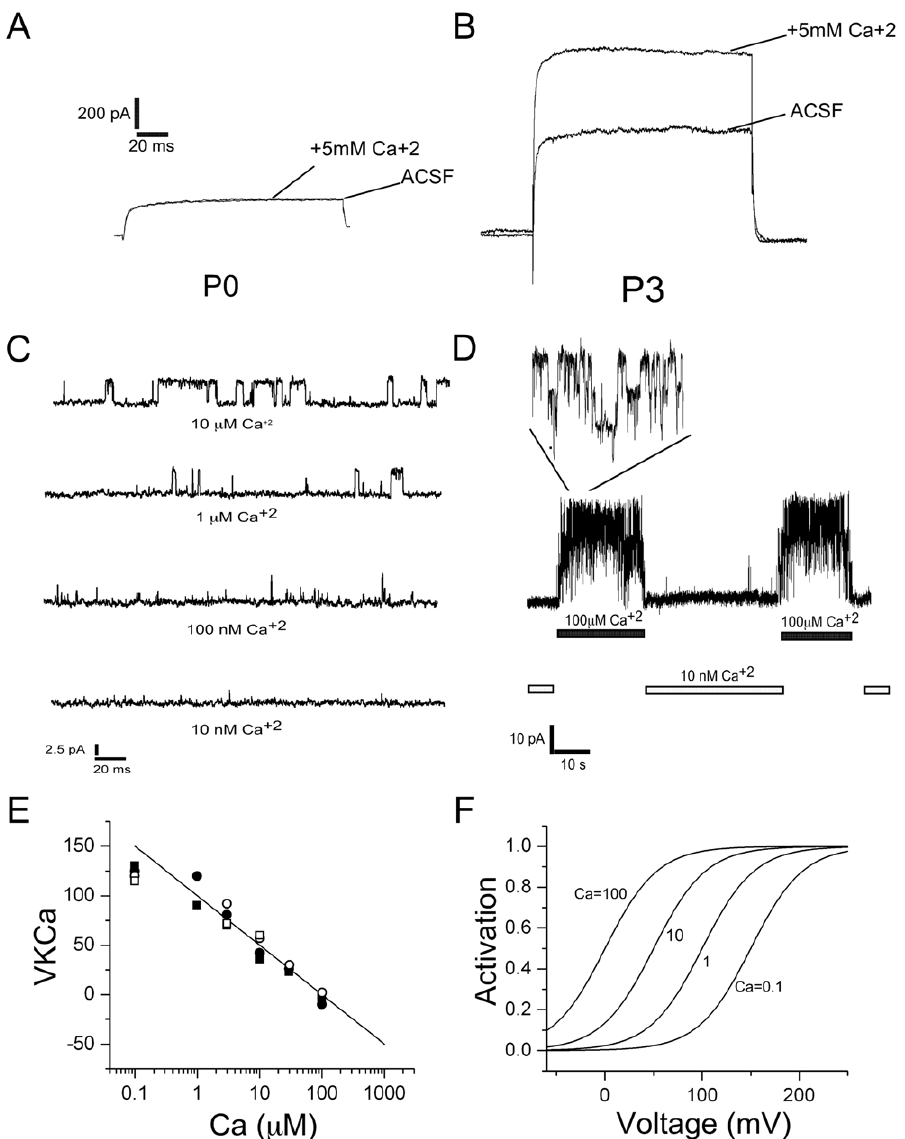
Figure 9. Ca 2 z sensitivity of the outward current and single-channel recordings. (A) Outward current of a P0 neuron in regular ACSF (no calcium) and in ACSF + 5 mM CaCl 2 . (B) Outward current of a P3 neuron in regular ACSF (no calcium) and in ACSF + 5 mM CaCl 2 . CaAK channels activated by intracellular Ca 2 z . Pipette solution as in the methods. (C) Single channel recordings on a P3 SN DA neuron at voltage recording=50 mV and Ca 2 z of ( m M): 10, 1, 0.1 and 0 (nominal zero). Single channel conductance c ~ 120 pS. (D) An excised inside-out patch obtained from a P3 SN DA neurons shows the presence of BK channels activated by internal Ca 2 z concentration (100 m M). V=100 mV, c ~ 120 pS. (E) Half-activation function of BK channels were obtained from single channel records such as in C. The half-point activation points were measured as a function of calcium. Open circles, P3, closed circles, P7. Closed diamond P14. Closed squares, P17. The solid fit represents the equation V B K ~ 50 mV log 10 (10 3 ½ Ca (cid:2) [Ca] Eq is 0.0001 mM. (F) Model of the activation function of BK channels as a function of voltage and calcium. The shift in the activation function were obtained from the mid point of the open channel probability and were fit using the function V BK , where [Ca] Eq is the equilibrium intracellular Ca concentration in mM (0.0001) and [Ca] int is the concentration at the mouth of the pore. For the curve labeled d, [Ca] int =[Ca] Eq and V BK =150 mV. For c, [Ca] int =10[Ca] Eq and V BK =150 mV. For b, [Ca] int =100[Ca] Eq and V BK =150 mV and for a, [Ca] int =1000[Ca] Eq and V BK =150 mV. These curves give the activation constant as a function of voltage and the calcium concentration in the vicinity of the channel according to equation (1), where K BK is 27 mV.